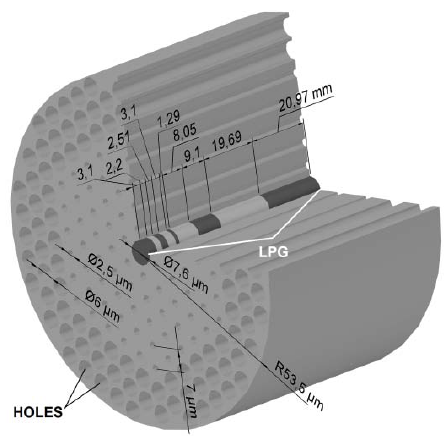
Figure 13. 3D sketch of the ytterbium-doped MOF laser with the MLPGs-A grating cascade [83].